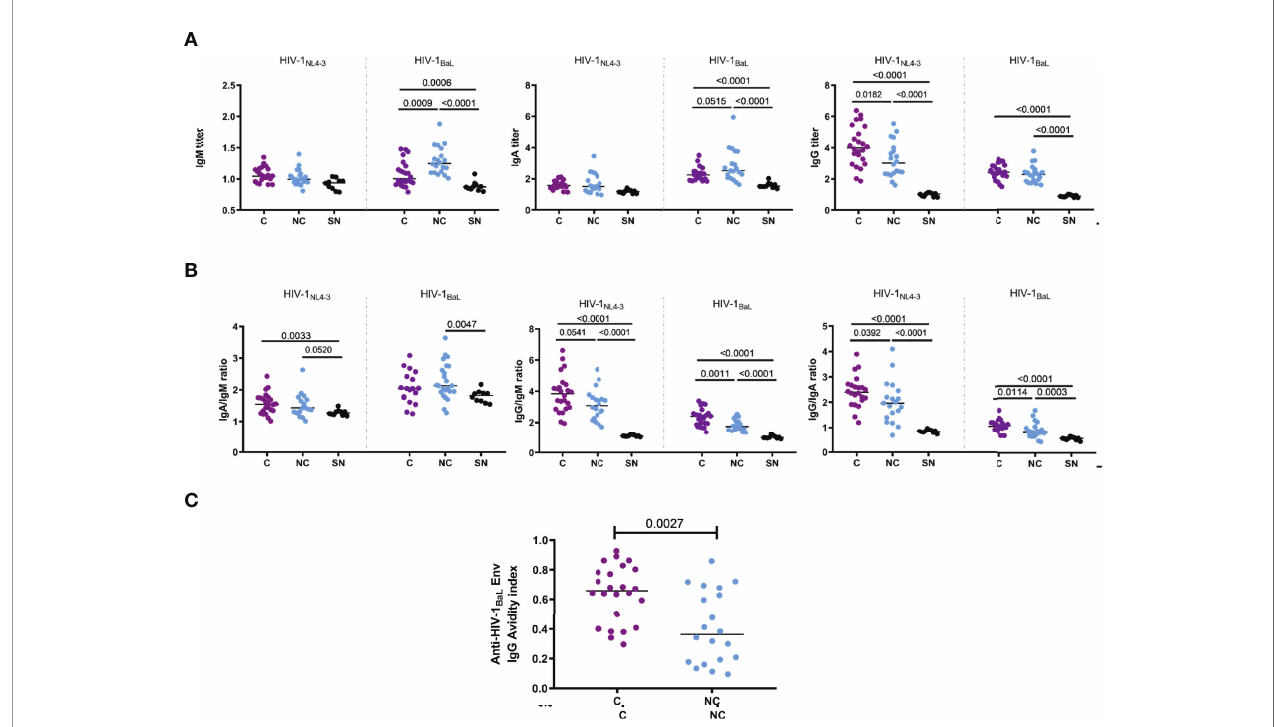
FIGURE 5 | Titers of anti-HIV Env lgA, lgG and lgM. Titers and af fi nity were compared between controllers (N=24, C, purple dots) and noncontrollers (N=20, NC, light blue dots) and HIV seronegatives (N= 8, SN, black dots). (A) Plasma dilution titers of anti-HIV Env lgA, lgG and lgM were determined with MOLT-4 cell lines expressing HIV-1NL4_3 and HIV-18AL Env in the surface. (B) lsotype class switching extend was estimated by the ratio of anti-HIV Env lgA/IgM, lgG/IgM and lgG/ IgA in each individual. (C) Avidity index of HIV-lsaL Env-speci fi c lgG. Statistical signi fi cance (p< 0.05) was evaluated by applying non-parametric Mann-Whitney